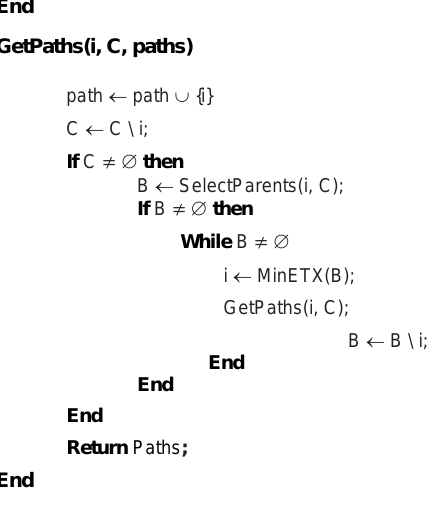
Figure 6. Pseudocode